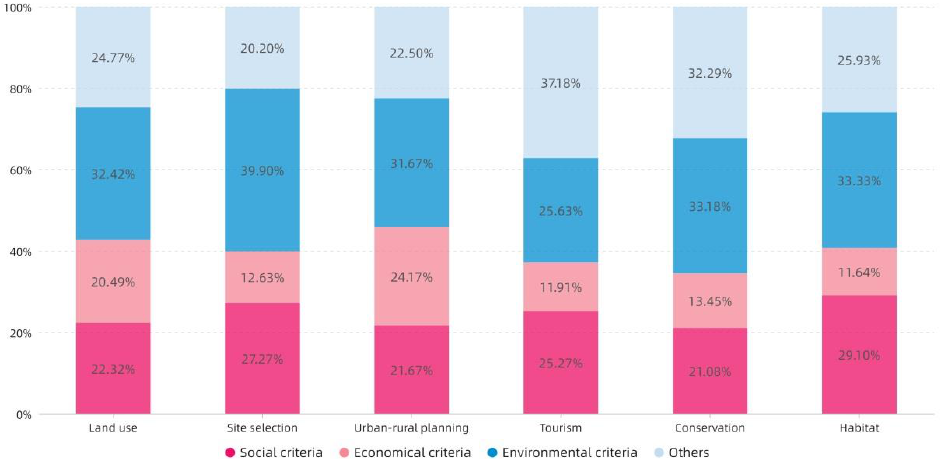
Figure 10. The topic distribution of the proportion of criteria. Figure 10. T he topic distribution of the proportion of criteria. Figure 10. T he topic distribution of the proportion of criteria. Content Analysis of